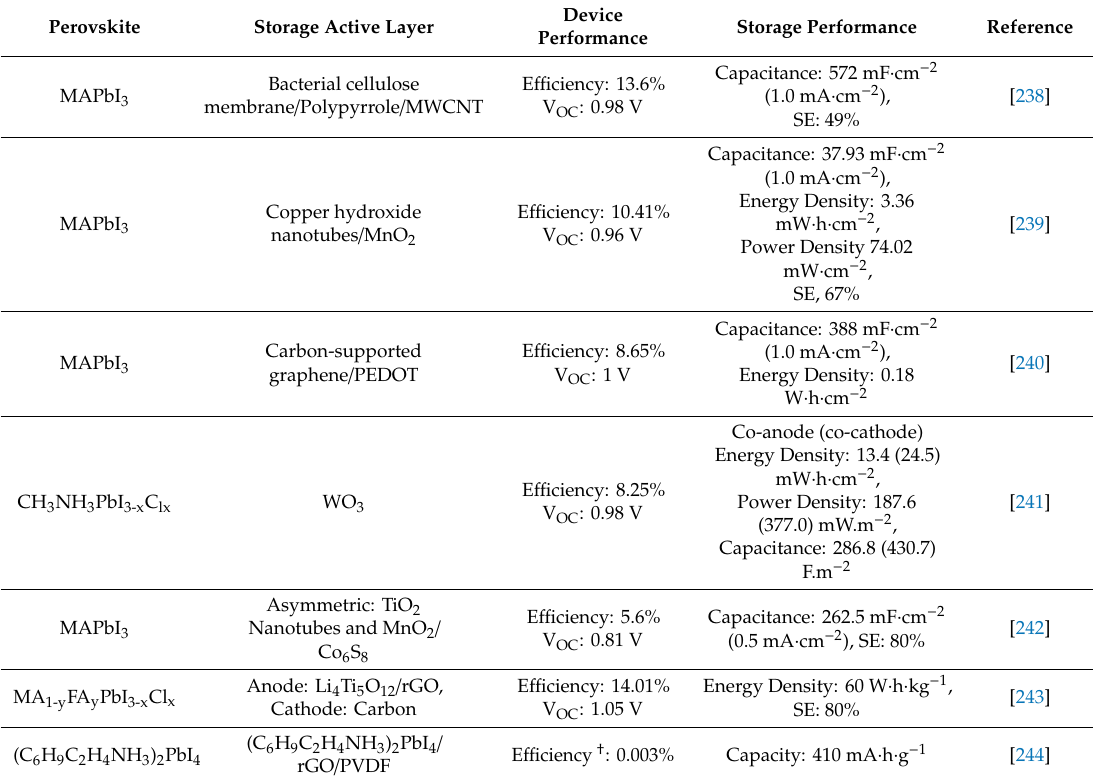
Table 7. Significant performance of various PSCs for electrochemical storage hybrid devices